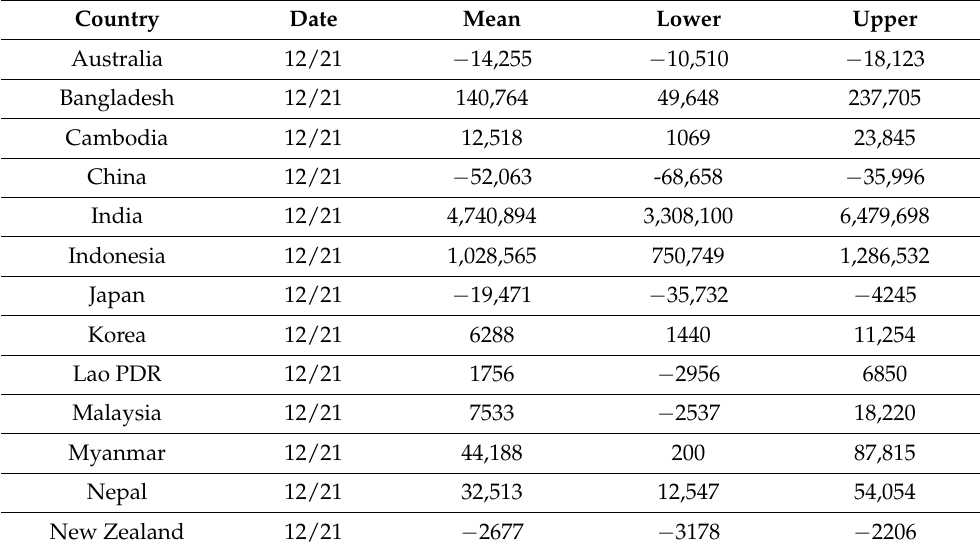
Table 2. COVID-19 Excess Deaths by Gender in selected countries of